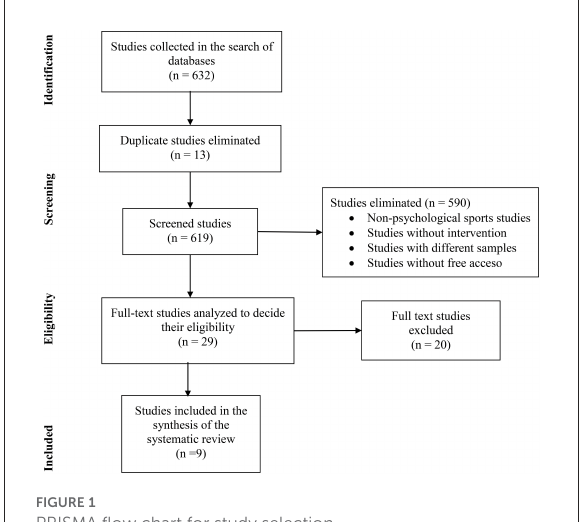
FIGURE1 PRISMA flow chart for study